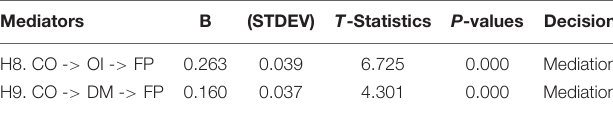
TABLE 4 | Indirect